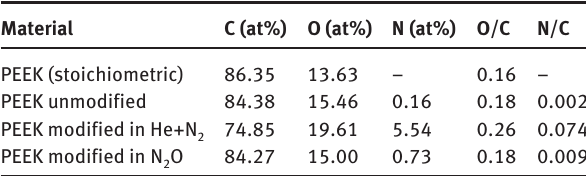
Table 3: Surface composition (excluding hydrogen) of PEEK without and after PECVD modification as studied by XPS; O/C and N/C ratios are also presented. In the first row theoretical values for stoichiometric PEEK are also shown for comparison Material